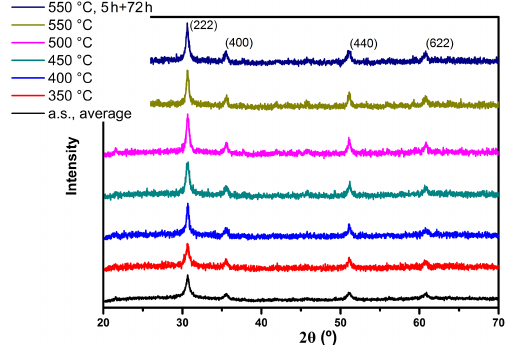
Figure 5. PXRD data: average of the as-synthesized samples and after heat treatments at different temperatures.